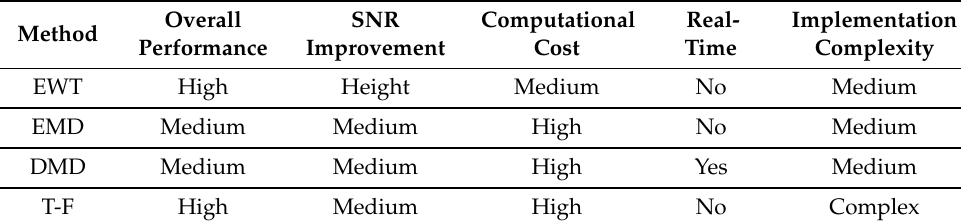
Table 3. Summary of the ECoG signal processing